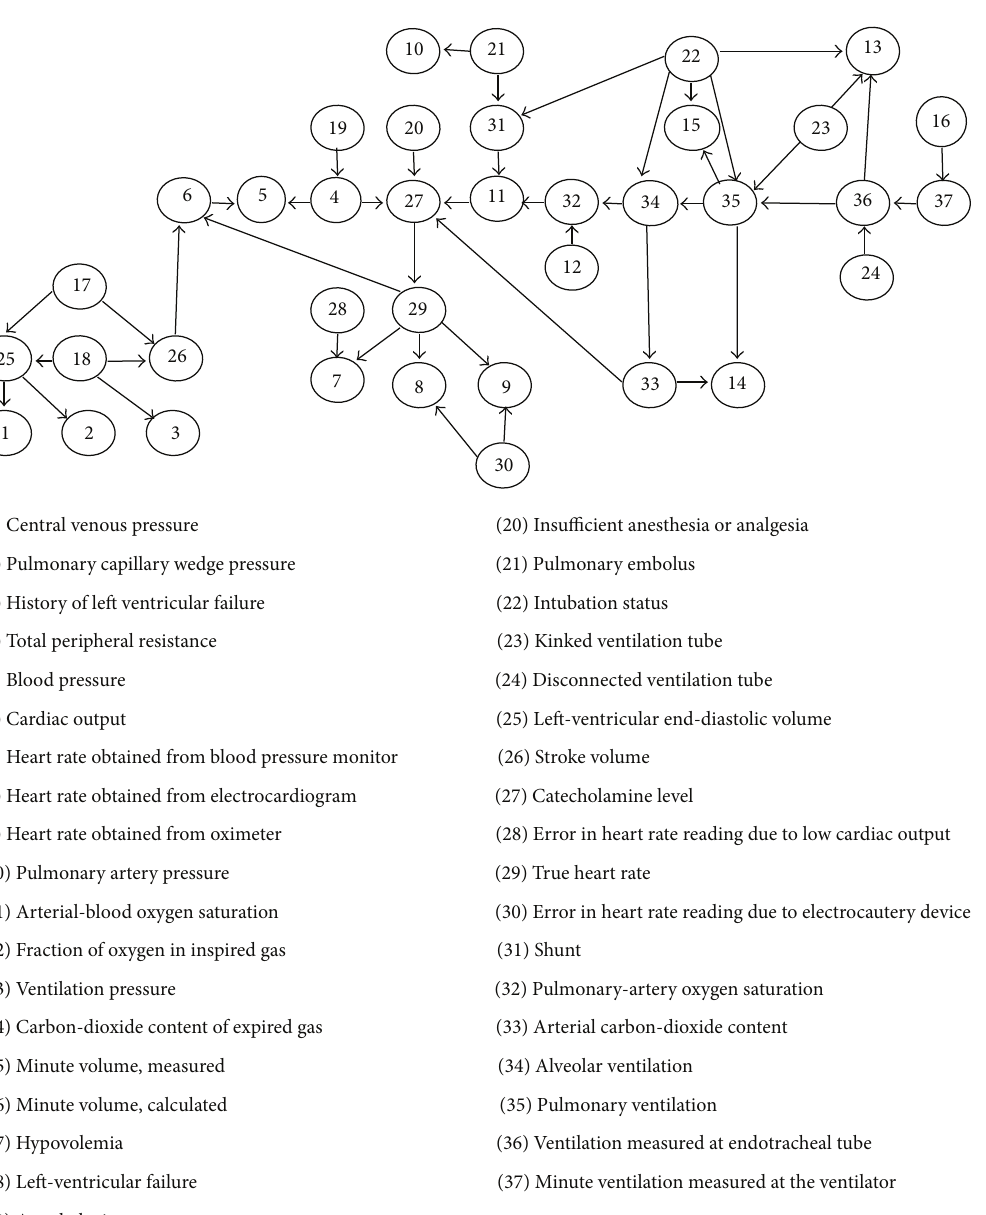
Figure 4: ALARM network structure and the variables defined in the network